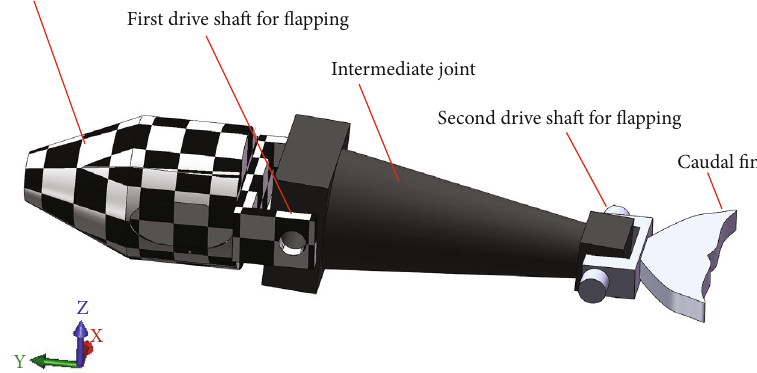
Figure 2: Equivalent model used as fl uid-solid coupling.